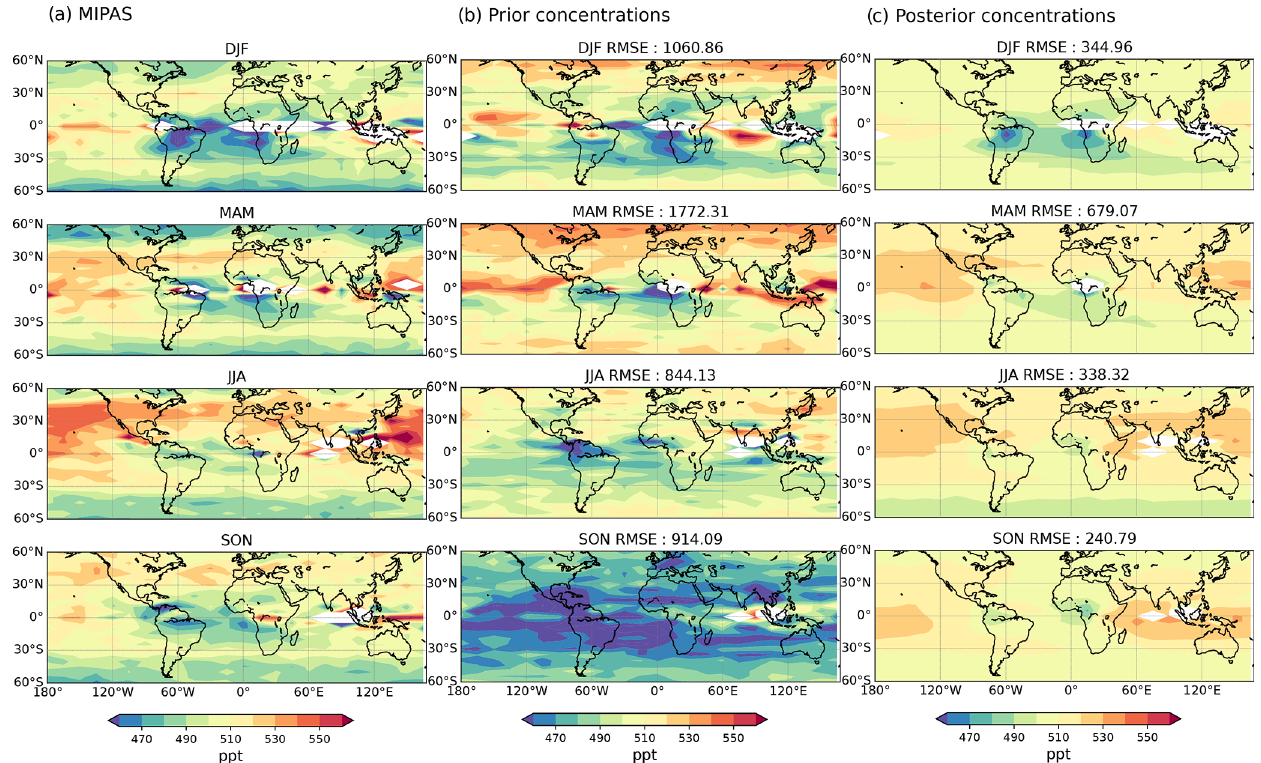
Figure 9. Climatological seasonal COS distributions at 250hPa measured by (a) MIPAS and simulated using the prior scenario (b) and (c) the optimized scenario. The datasets cover the years 2008–2012, and the displayed seasons are (top row) December to February, (second row) March to May, (third row) June to August and (fourth row) September to November. White areas are data gaps, and dark blue COS amounts above the Amazonian region (bottom left) are below 450pptv. The negative bias in the prior concentrations, which results from the unbalanced COS prior budget, has been removed in (c) . The RMSE (see Eq. 8) is shown above each panel. The bias in the prior concentrations has been removed before computing the RMSE.